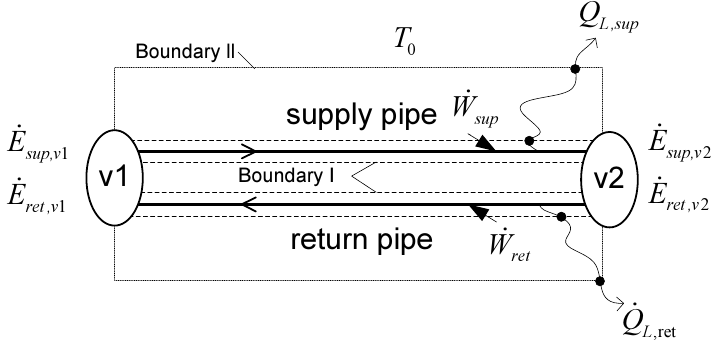
Figure 3. Supply line with heat transfer to the